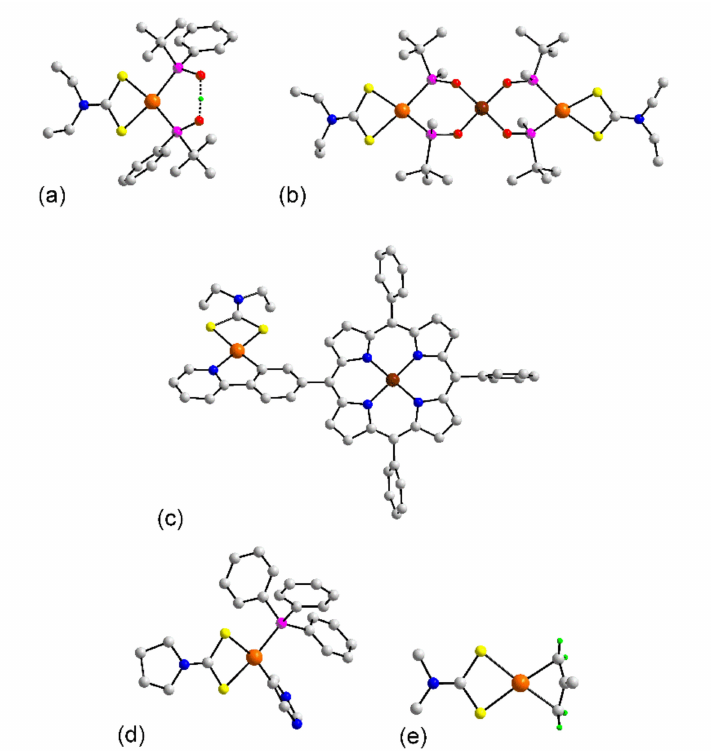
Figure 9. Molecular structures of palladium complexes: ( a ) [tBu(Ph)POH][tBu(Ph)P(=O)]Pd( L 24 ) ( 147 ), ( b ) Cu{[tBu(PhP)(O)]Pd( L 24 )} 2 ( 148 ), ( c ) Pd(X 3 )( L 24 ) in 152 , ( d ) (PPh 3 )Pd(pyr)( L 57 ) ( 154 ), and ( e ) Pd( η 3 -C 4 H 7 )( L 8 ) ( 155 ). In ( b ), only the ispo-C atoms of the phosphane bound phenyl rings are shown for clarity.